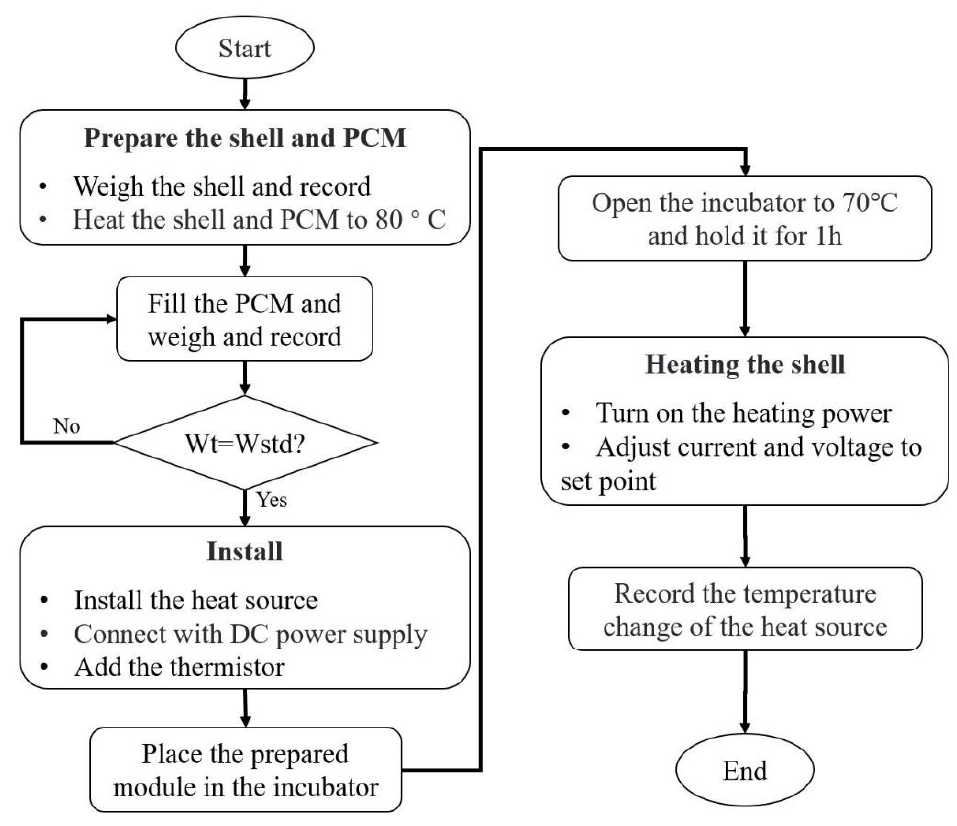
Figure 5. Flow chart of the experiment.